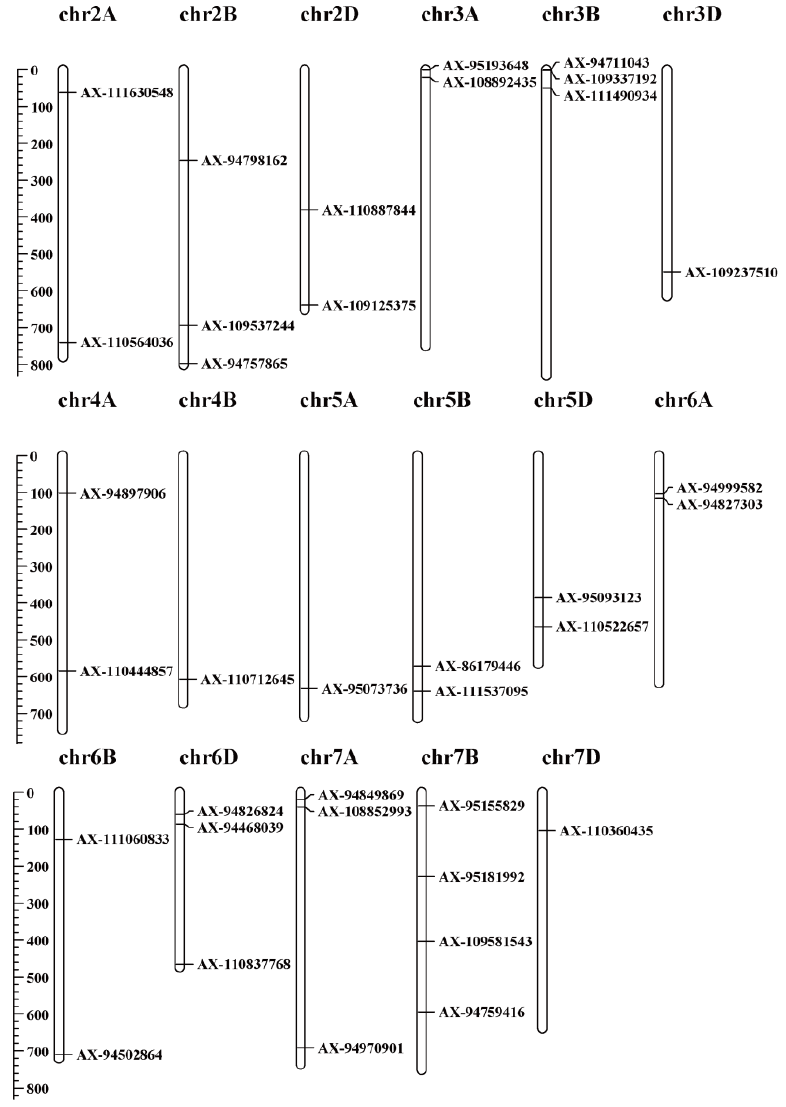
Figure 4. Location of the QTLs for the RSA traits ( − log 10 [ p -value] ≥ 4). Table 4. QTLs and QTL clusters with RSA traits and overlapping with QTLs from previous stud- ies. QTL clusters refer to the QTLs that were associated with more than one RSA trait. We identified 13 QTL clusters located on chromosomes 2A, 2B, 3A, 3B, 3D, 4A, 5B, 5D, 6B, and 7B. Chromosomes 2A, 3B, and 7B contained two QTL clusters, and chromosomes 2B, 3A, 3D, 4A, 5B, 5D, and 6B harboured a single QTL cluster. One QTL cluster on chromosome 5B (571.23 Mb) was associated with five RSA traits: RL, RA, RV, RT, and NRT. One QTL cluster on chromosome 3D (549.74 Mb) was associated with four RSA traits: RL, RA, RV, and TRL. Two QTL clusters on chromosome 2A (61.28 Mb and 740.01 Mb) and one QTL cluster on chromosome 2B (694.26 Mb) were associated with TRA and TRV. Two QTL clusters on chromosome 7B were associated with TRL and TRA. One QTL cluster on chromosome 3A, two on chromosome 3B, one on chromosome 4A, one on chromosome 5D, and one on chromosome 6B were associated with RT and NRT. Therefore, these QTL clusters showed a pleiotropic